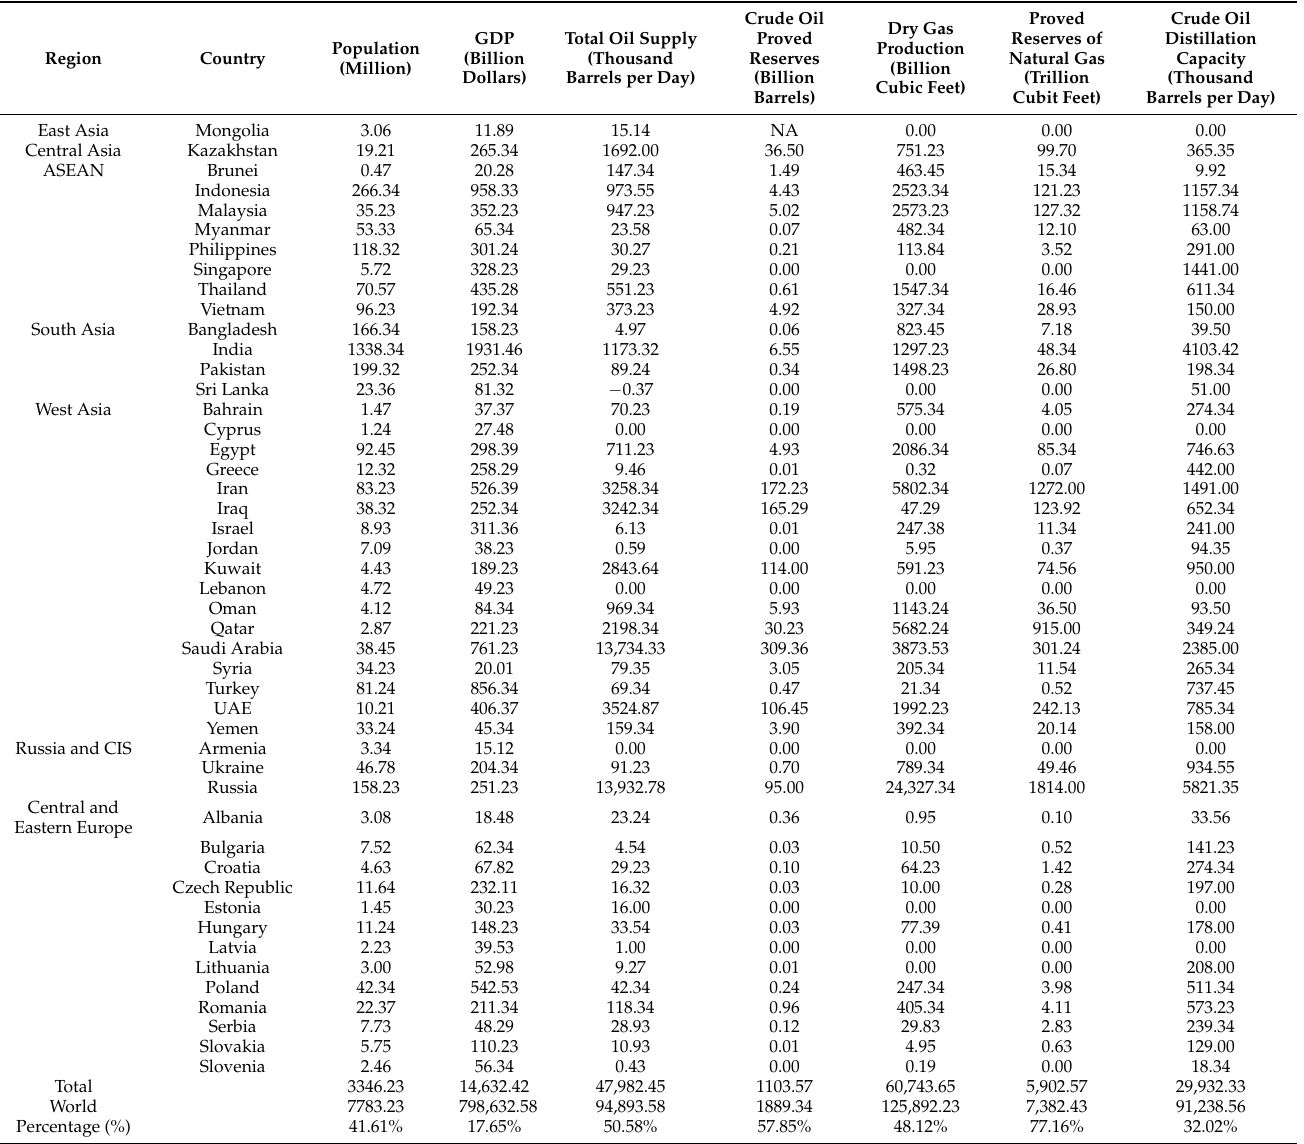
Table A7. Main statistics of 50 Nations alongside the China’s “Belt & Road Initiative in 2019”.